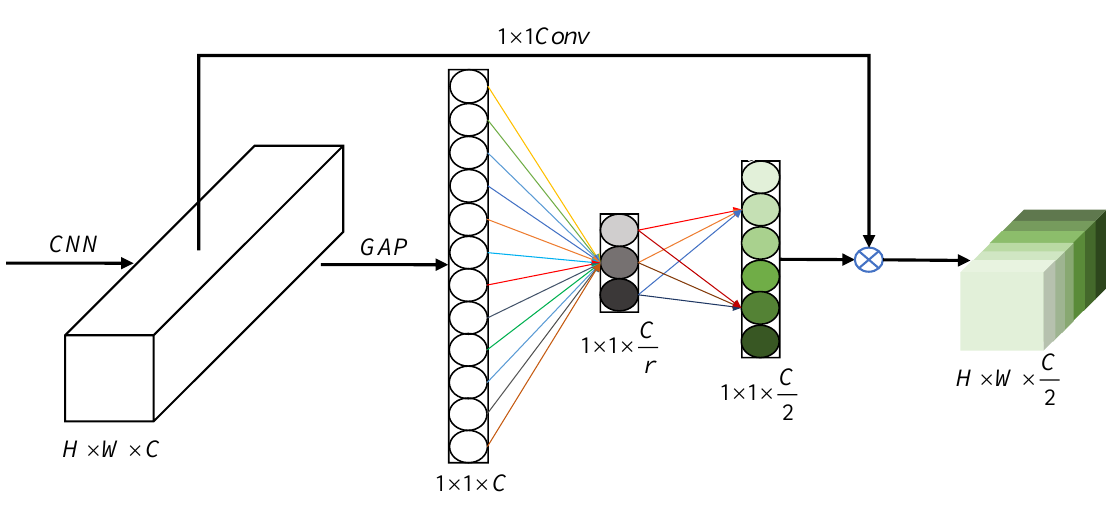
Figure 2. The structure of Channel Feature Compression module. ‘ GAP ’ represents the global average pooling operation. ‘ r ’ is the reduction ratio. ‘ H × W × C ’ represents the shape of the